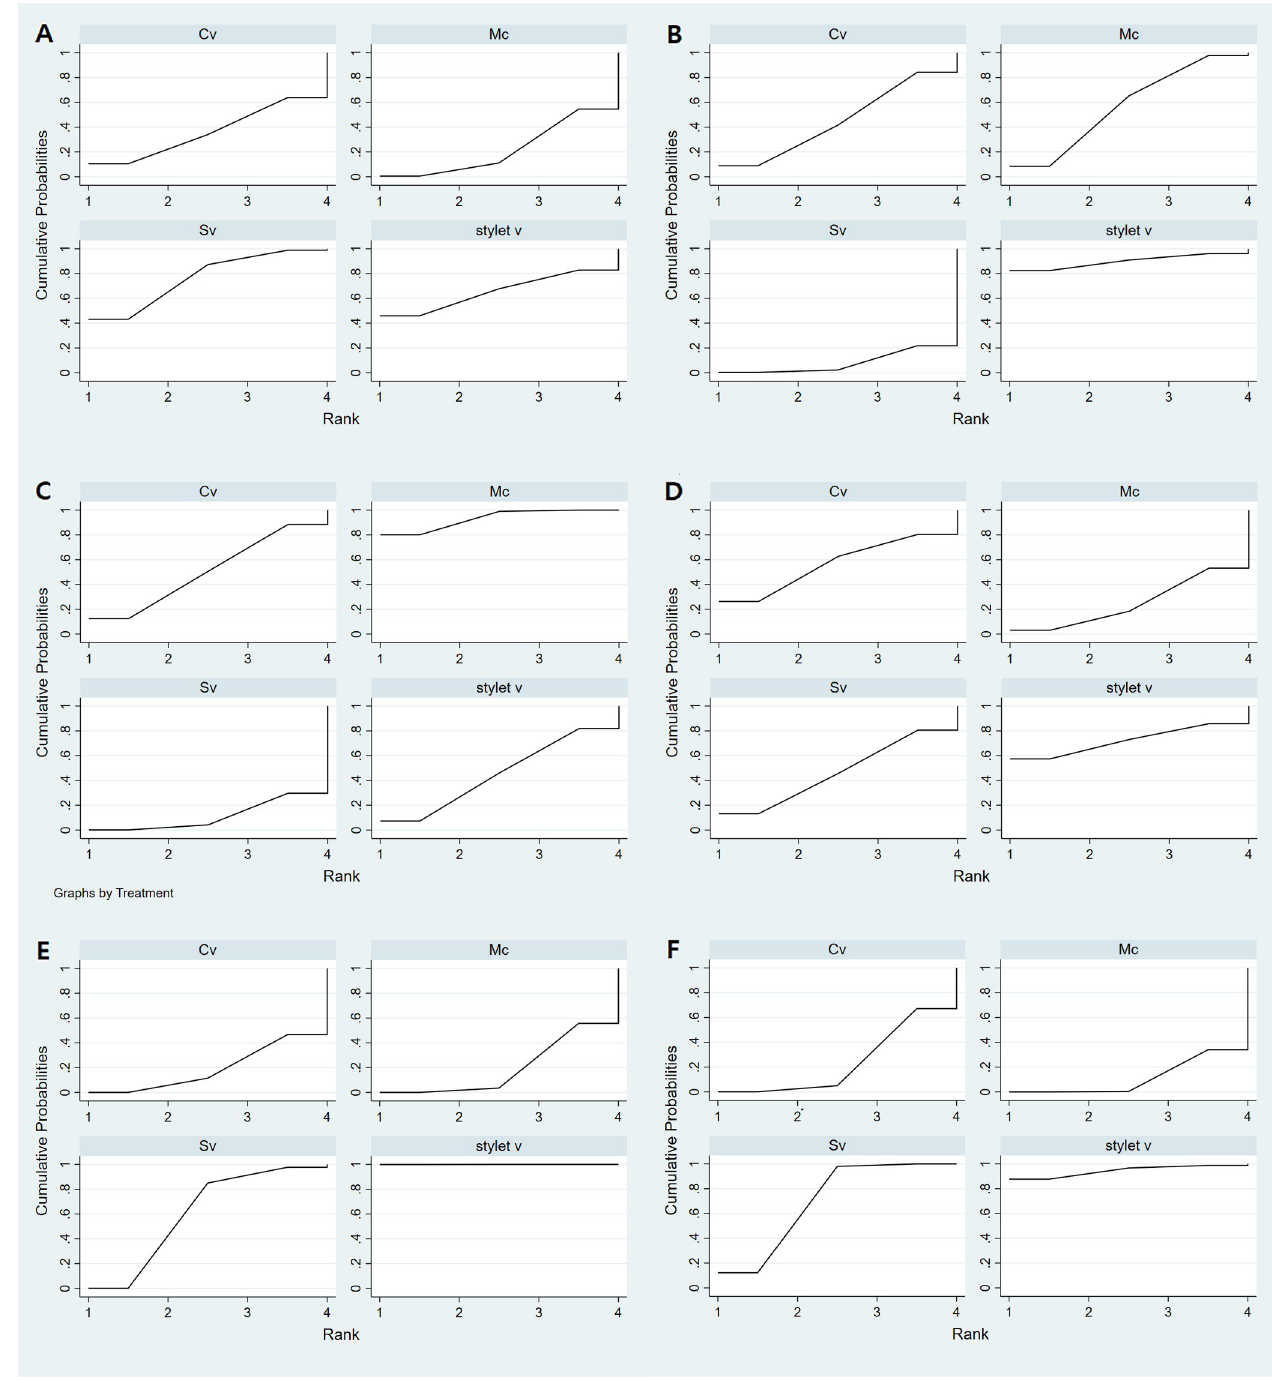
Fig 6. The cumulative ranking curve of the outcomes of the different laryngoscopes. The surface under the cumulative ranking curve (SUCRA) represents the ranking of devices. A higher SUCRA suggests a higher probability of being a good device. (A) The success rate of the first attempt, (B) intubation time, (C) malposition, (D) sore throat, (E) oral mucosal damage, and (F) external manipulation. Mc, Macintosh (direct) laryngoscope; SV, standard non-channeled videolaryngoscope; CV, channeled videolaryngoscope; stylet V, videostylet.